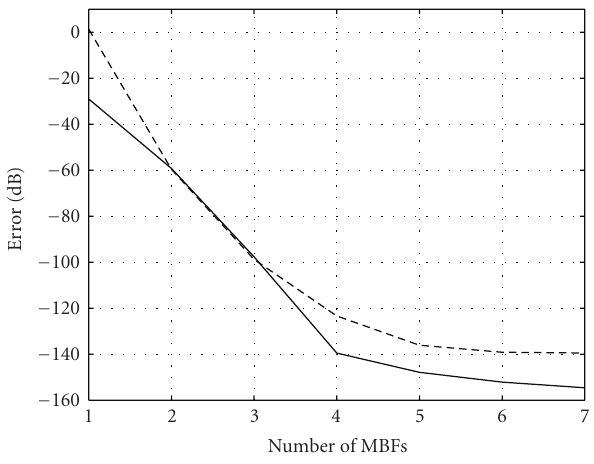
Figure 6: Errors versus number of MBFs between ASM-MBF and brute-force solutions for a 17-dipoles array excited at first element. Solid: without eigenmodes. Dashed: with eigenmodes.